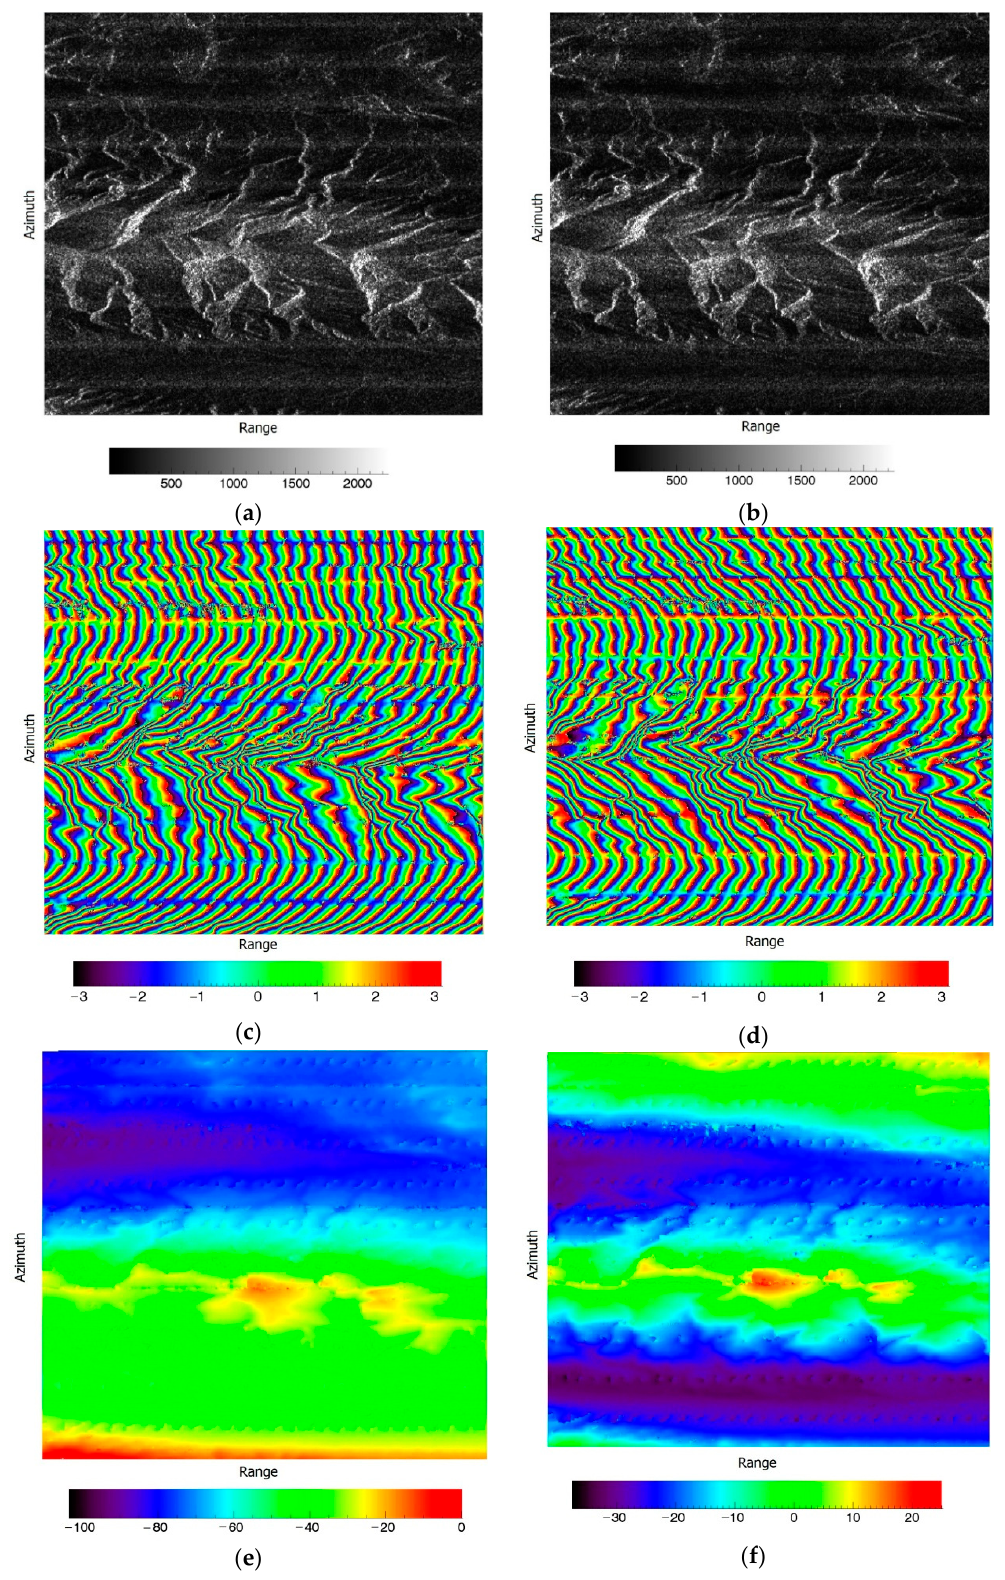
Figure 6. The linear compensation results. ( a ) The master image; ( b ) the slave image; ( c ) the original denoised interferometric phase (rad); ( d ) the compensated denoised interferometric phase (rad); ( e ) the original unwrapped phase after flat Earth removal along the range direction (rad); ( f ) the compensated unwrapped phase after flat Earth removal along the range direction (rad).